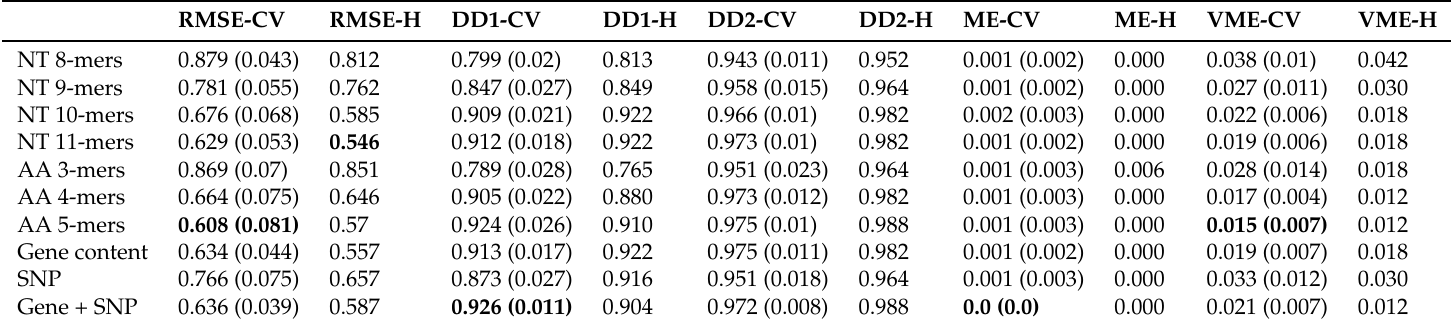
Table A35. K. pneumoniae –gentamicin.